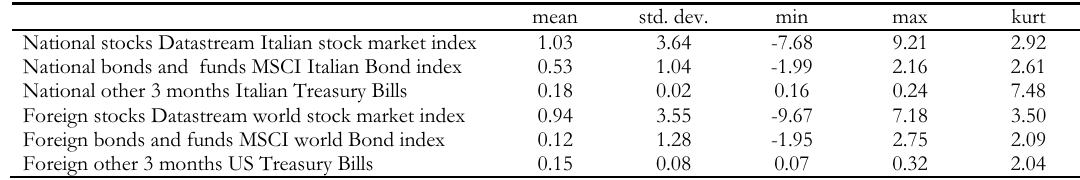
Italian households financial investments monthly returns in Euros 2003-2005 mean std. dev. min max